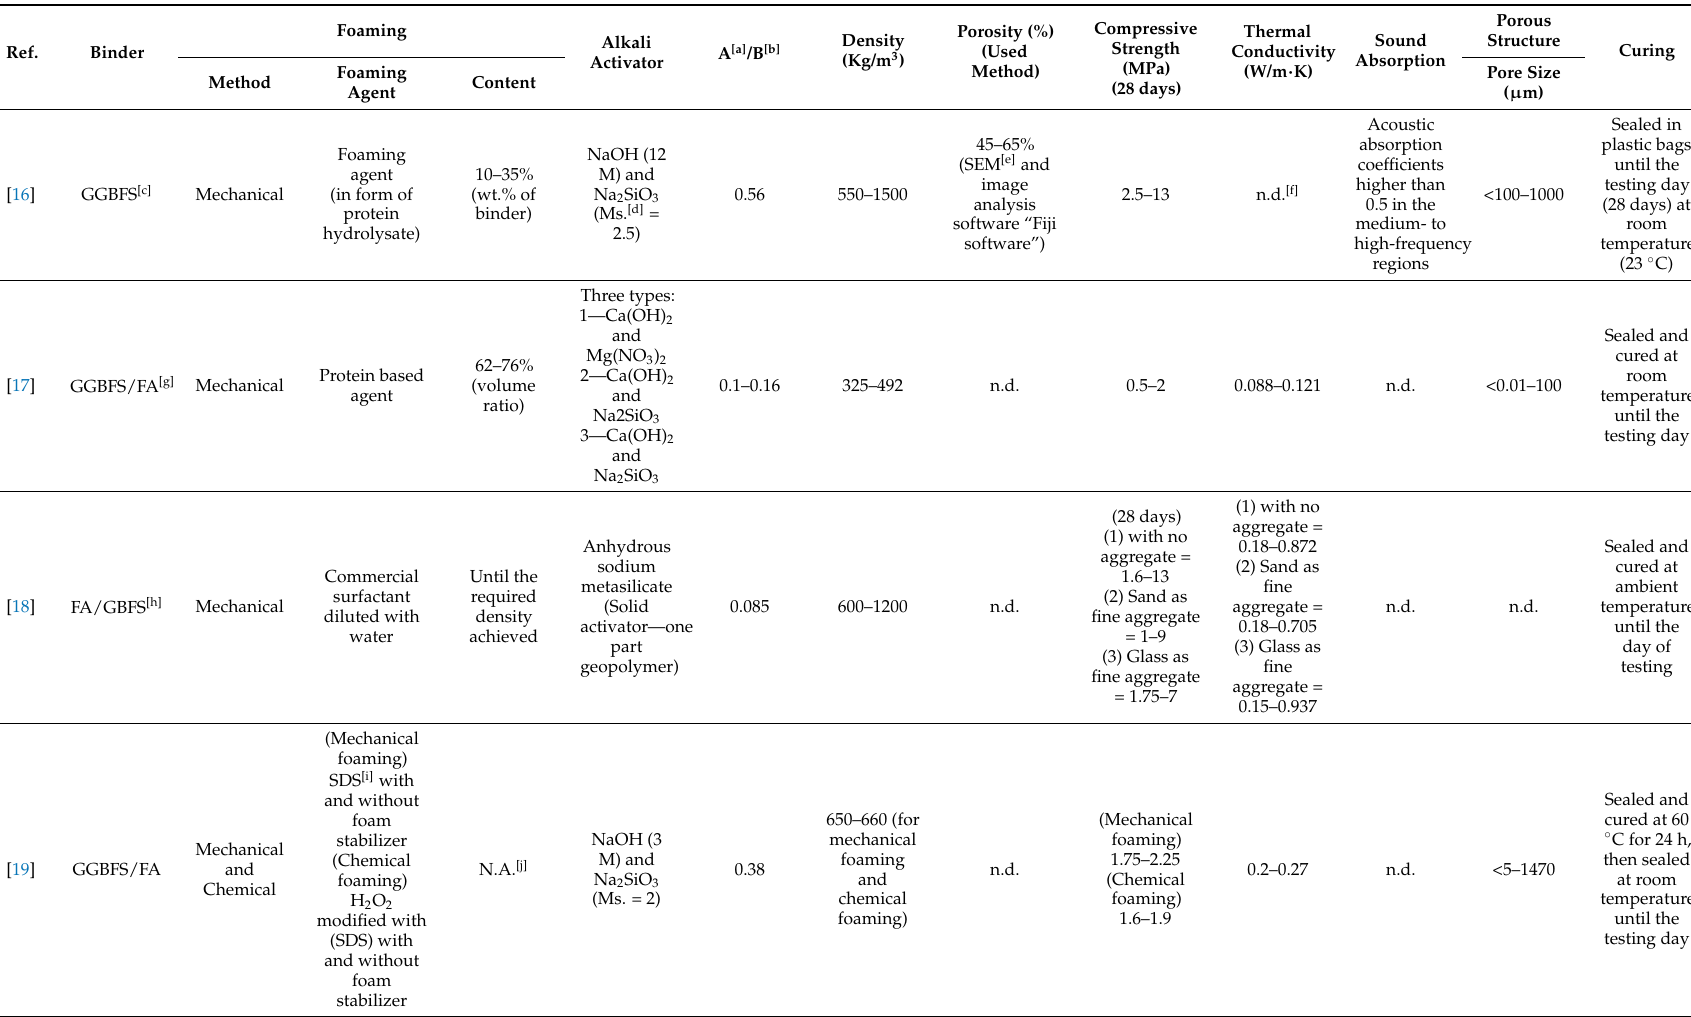
Table 1. Properties of alkali-activated foam concrete (by mechanical foaming